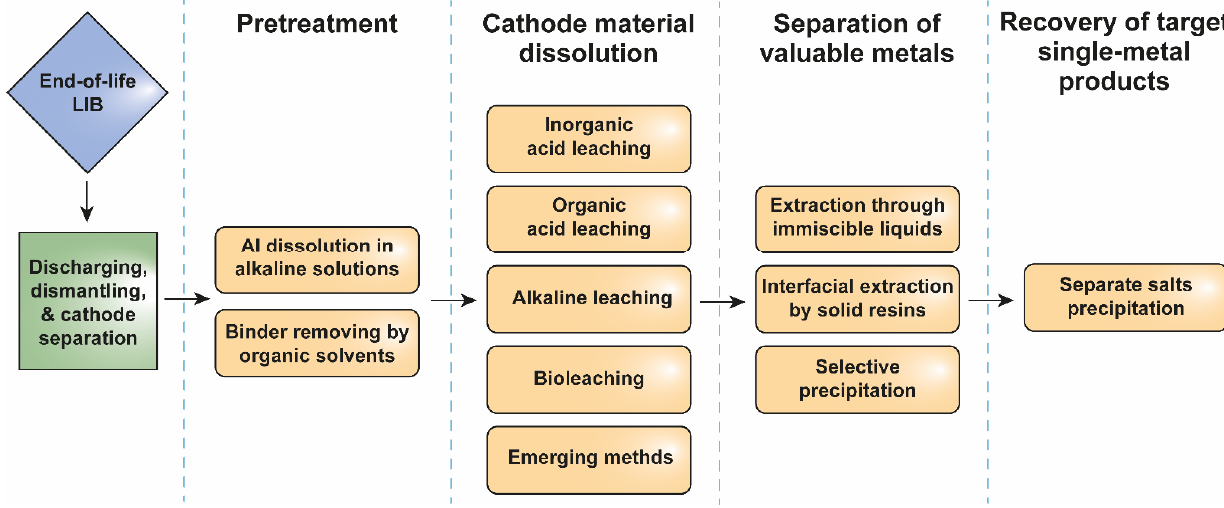
Figure 6. Common roadmap for the hydrometallurgical process of LIB cathodes recycling. Active Material Detaching and Binder Removing